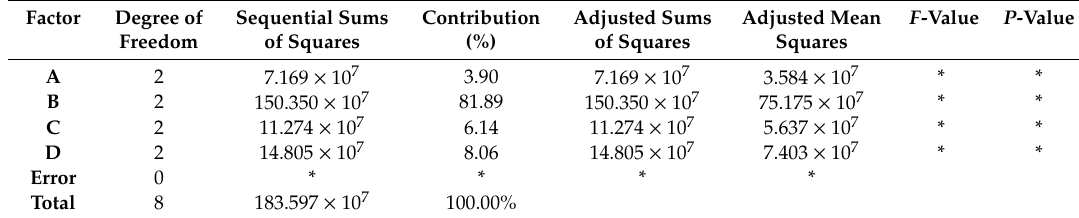
Table 5. ANOVA results for